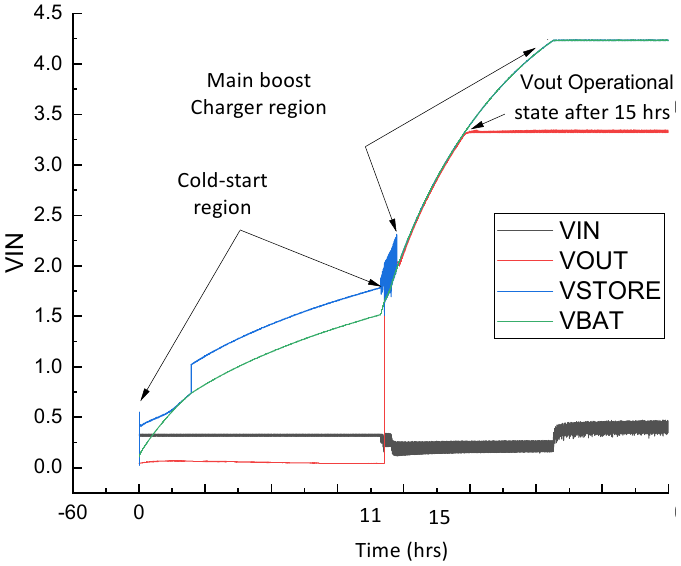
Figure 10. Cold start forage-grass-power cell analysis.